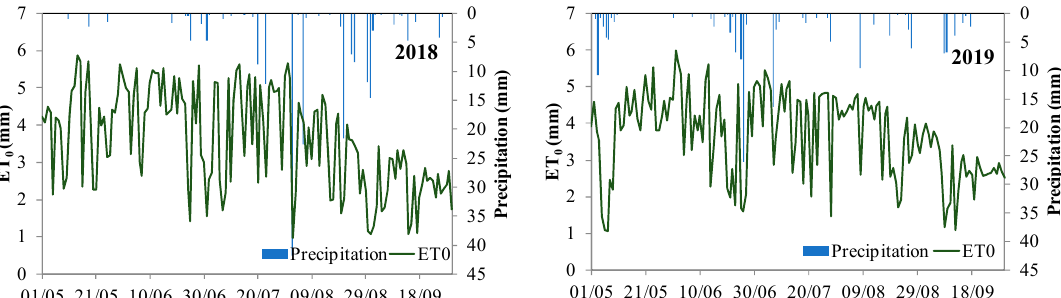
Figure 2. Daily reference evapotranspiration ( ET 0 ) and precipitation during the whole growth period of